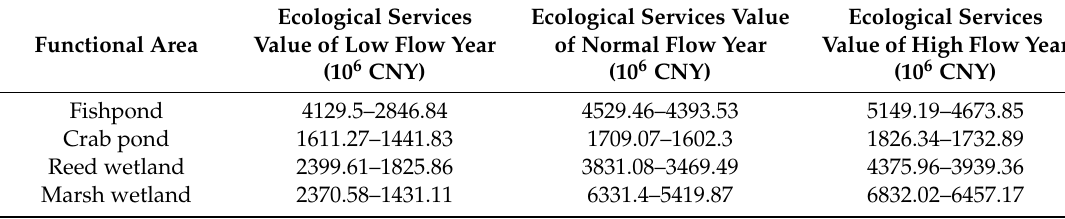
Table 3. Interval value of the ecological service values of di ff erent functional areas.